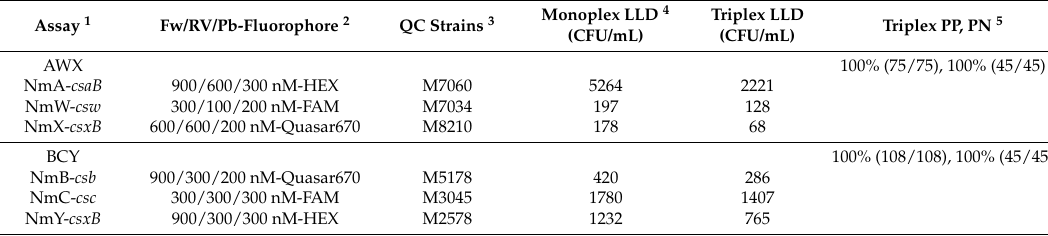
Table 1. Characteristics of direct monoplex and triplex real-time PCR assays for meningococcal serogroup